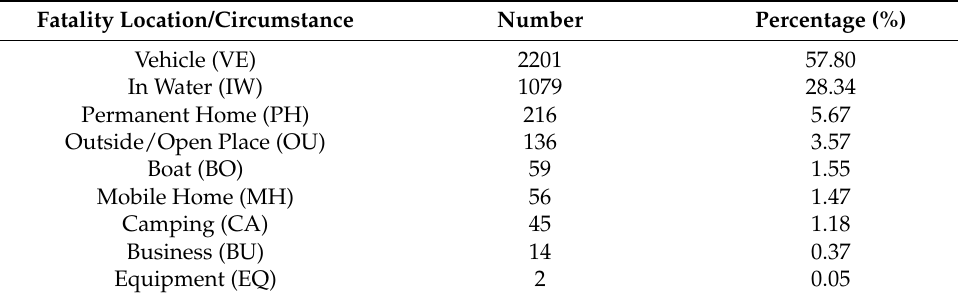
Table 4. Number of flood fatalities by location/circumstances.